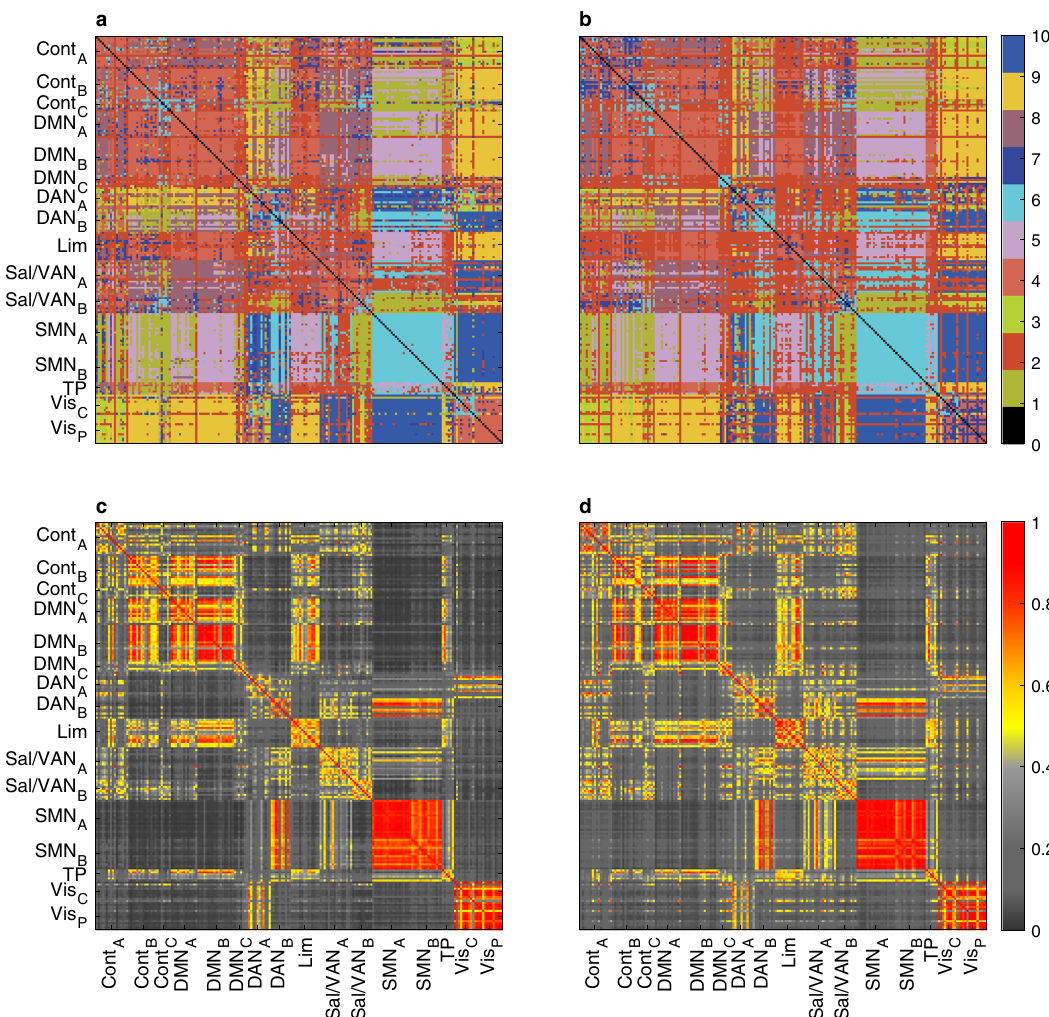
Fig. 2 The edge communities can be predicted from the nFC under the static Gaussian null model. a Empirical edge communities obtained by k-means clustering of the eFC computed on the HCP dataset. The edge labels are reshaped into an NxN matrix where each ( i , j ) entry represents the community label of the edge linking i to j . For each edge, the representative community assignment shown here is the statistical mode (i.e., the most common label) across 100 HCP subjects. b Predicted edge communities obtained by k-means clustering of the eFC predicted by the static null model. The agreement with the empirical labels in panel a is exact on 84% of all 19900 edges (74% if GSR is applied). c Empirical edge cluster similarity on the HCP dataset. The similarity of edge communities involving nodes i and j is computed as the fraction of matching elements between the corresponding two rows of the edge community matrix in panel a . d Predicted edge cluster similarity based on the static null model. The Pearson correlation with the empirical edge cluster similarity in panel c is r = 0.96 ( r = 0.95 if GSR is